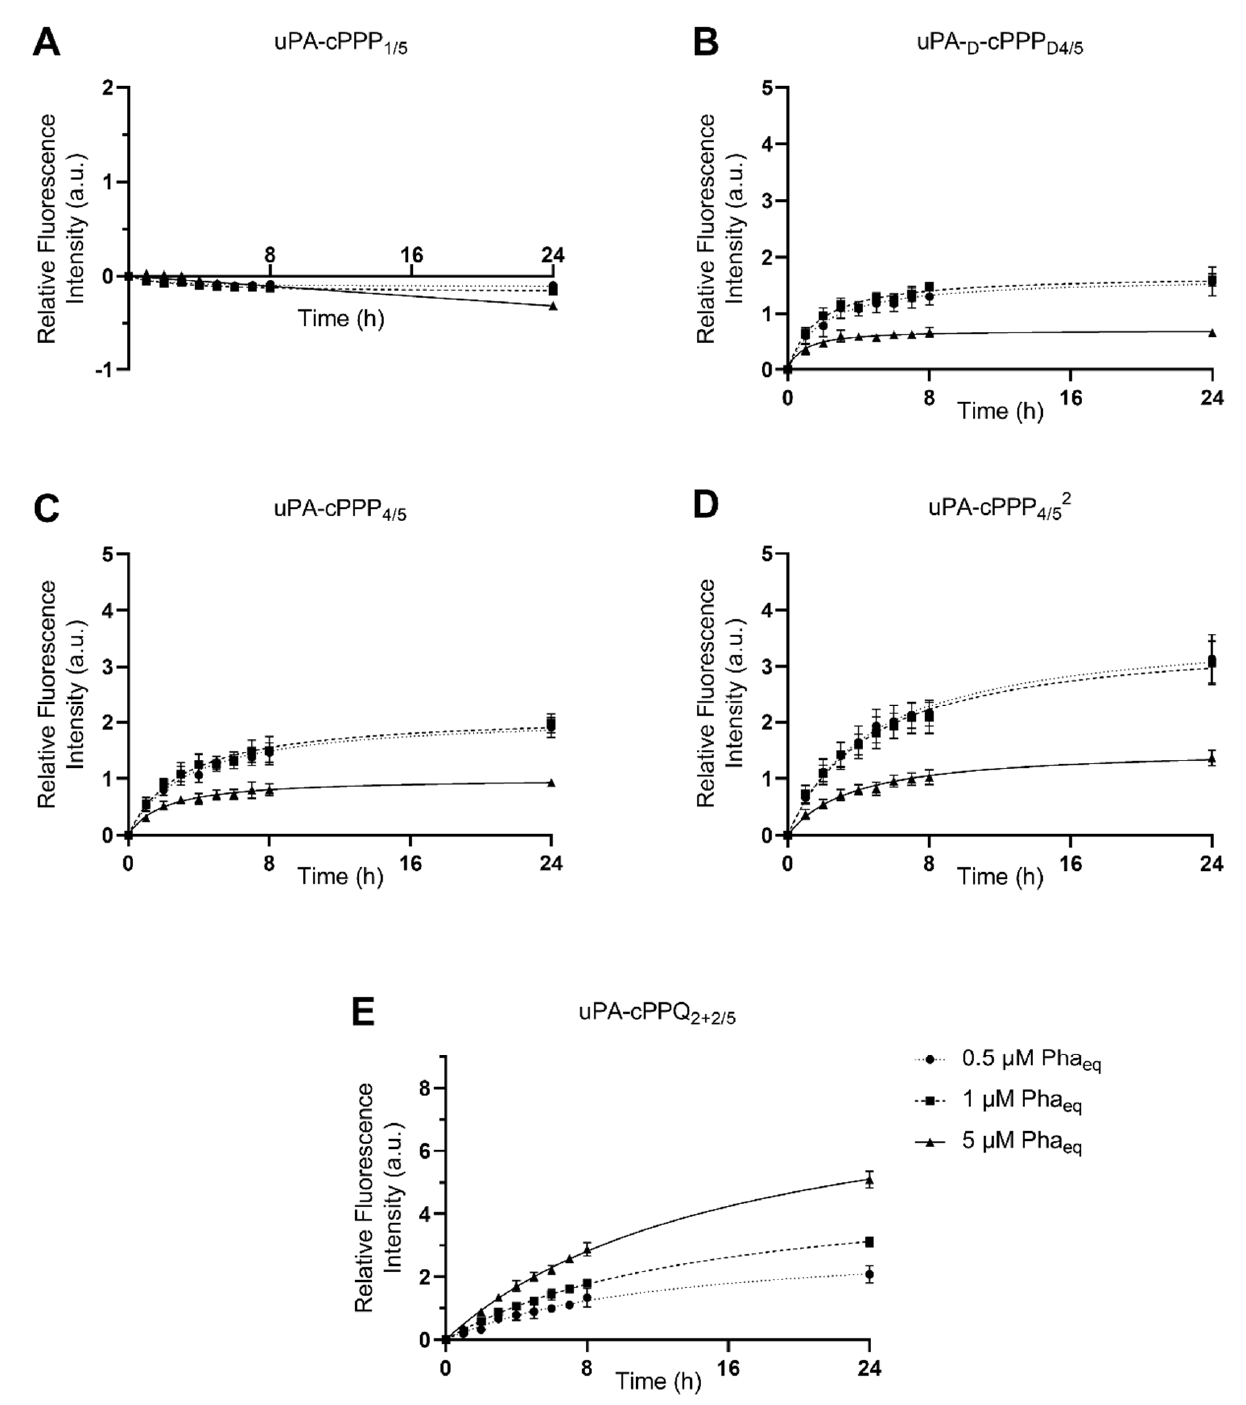
Figure 2. Red fluorescence emission of A549 cells upon incubation with 0.5 µM, 1 µM or 5 µM of ( A ) uPA-cPPP 1/5 , ( B ) uPA- D -cPPP D4/5 , ( C ) uPA-cPPP 4/5 , ( D ) uPA-cPPP 4/5 2 or ( E ) uPA-cPPQ 2+2/5 (n = 3 to 4; mean ± SD).